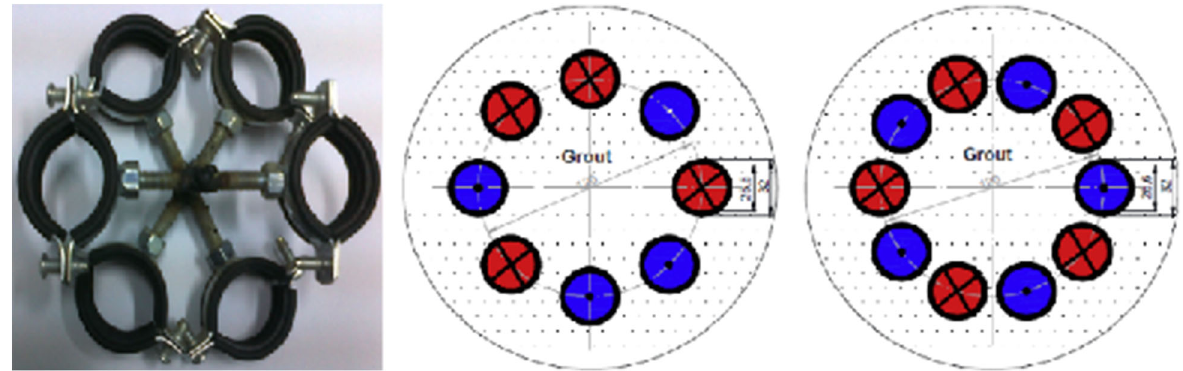
Fig. 20 Multi-pipe borehole heat exchangers [16]